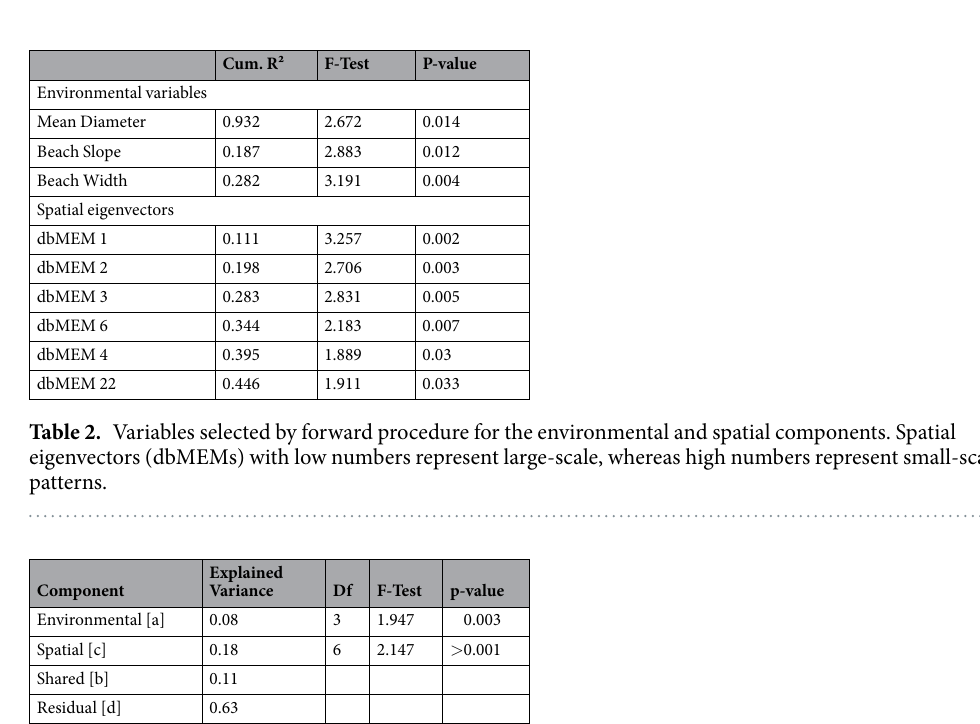
Table 1. Environmental characterization of the studied sandy beaches. M.D. stands for grain mean diameter, O.M. for organic matter content, and BI for beach index. Sampling periods are pooled, as no significant changes were found among periods for each variable.